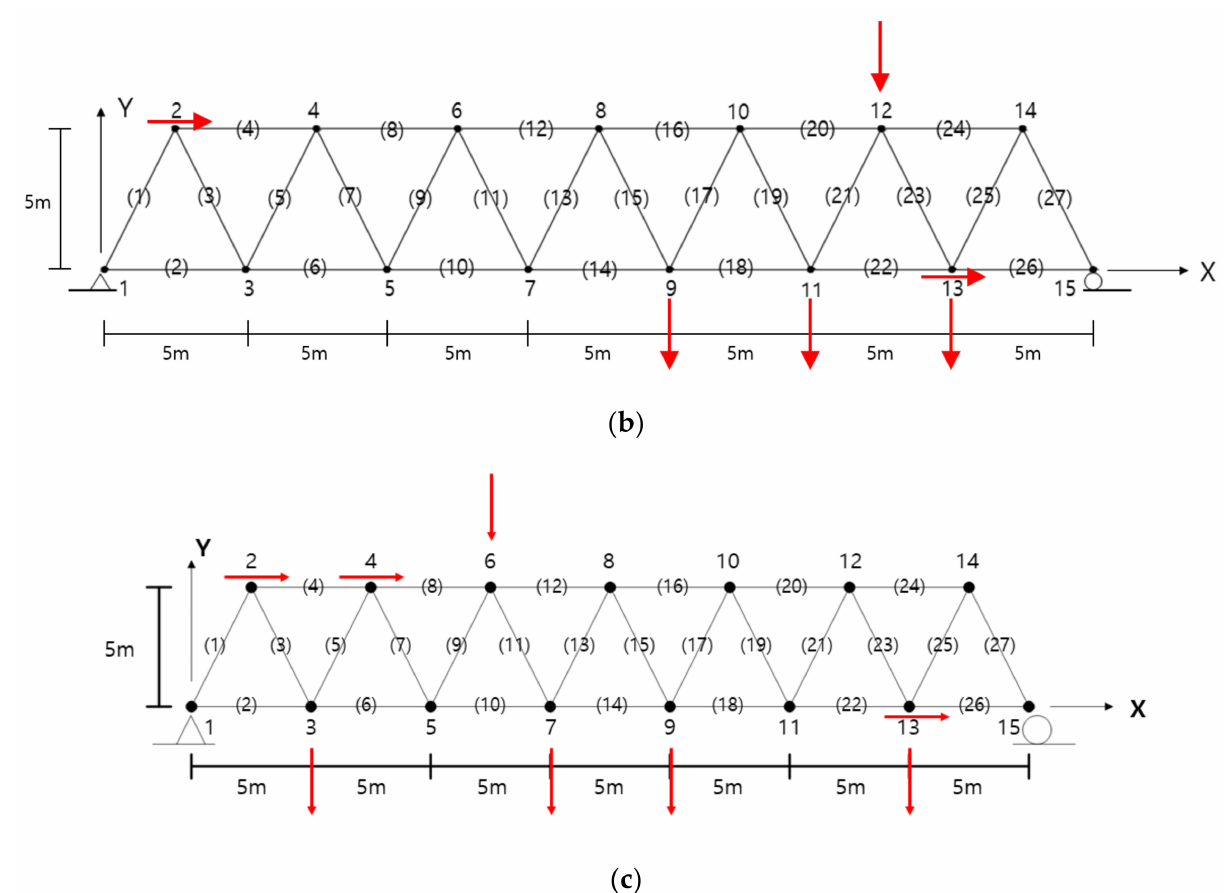
Figure 5. Final sensor layout: ( a ) MAC approach; ( b ) EI approach; ( c ) Sun & Buyukozturk. Numbers in parentheses indicate member and arrows indicate the position and direction of the